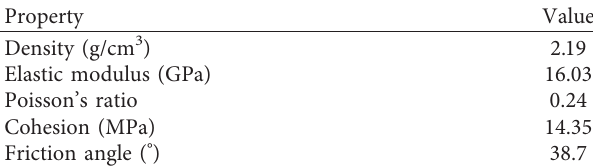
Table 1: Physical and mechanical properties of the cement mortar.